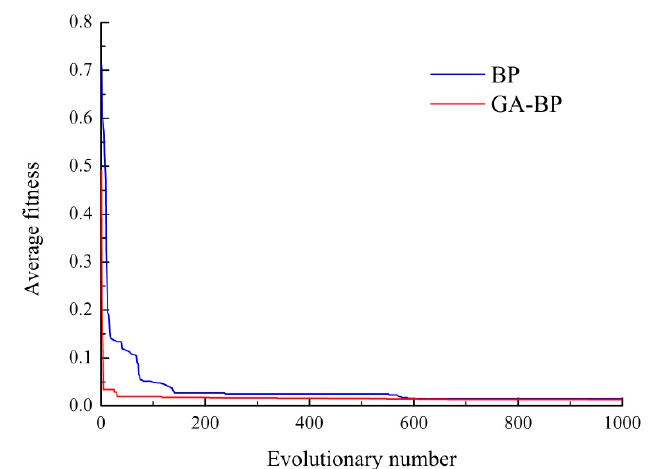
Figure 9. The average fitness